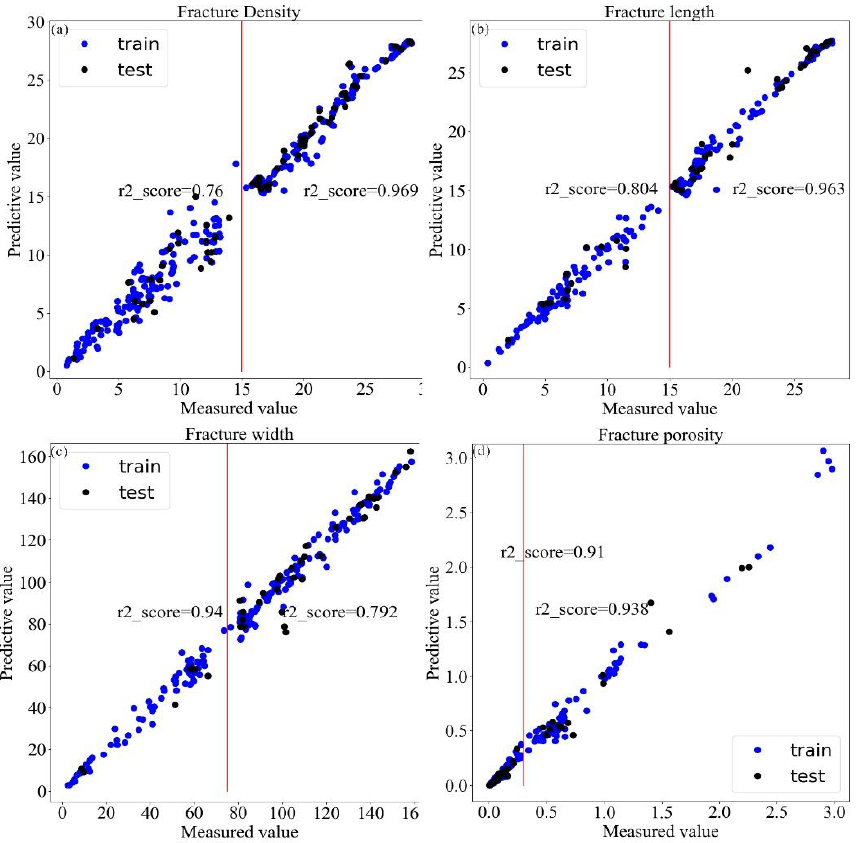
Figure 5. Comparison between the measured and predicted fracture parameters. ( a ) Fracture den- sity; ( b ) Fracture length; ( c ) Fracture width; ( d ) Fracture porosity.